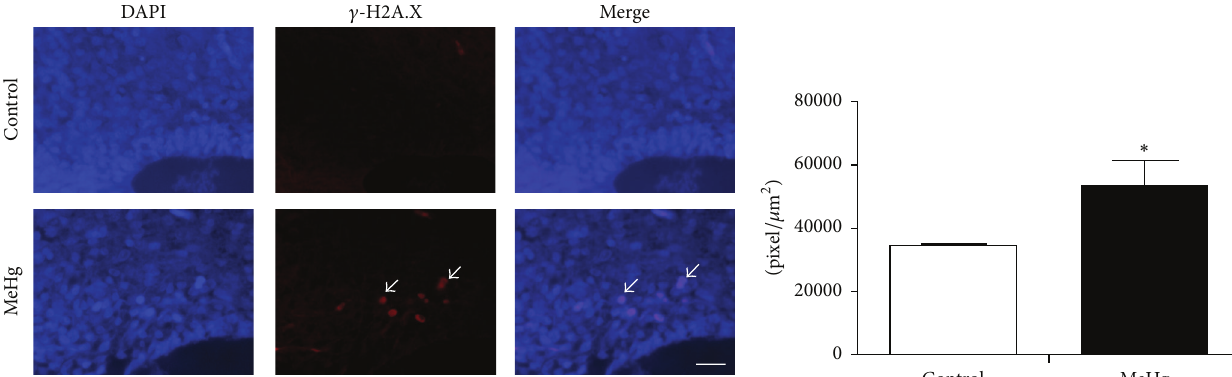
Figure 5: DNA double-strand breaks labeled with 𝛾 -H2A.X antibody analyzed by immunohistochemistry. 𝛾 -H2A.X-positive cells (arrows) wereobservedinMeHg-treatedembryos.Thegraphdisplaystheexpressionprofileof 𝛾 -H2A.XinthespinalcordofcontrolandMeHg-treated embryos. Integrated density of pixels of the fluorescence of the 𝛾 -H2A.X was determined, and data are expressed as mean ± SEM. ∗ 𝑃 < 0.05 . Scale bar: 10 𝜇 m.